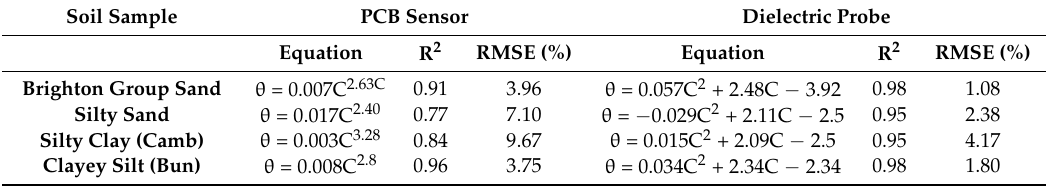
Table 6. Summary of the PCB sensor and dielectric probe performance against each soil sample.